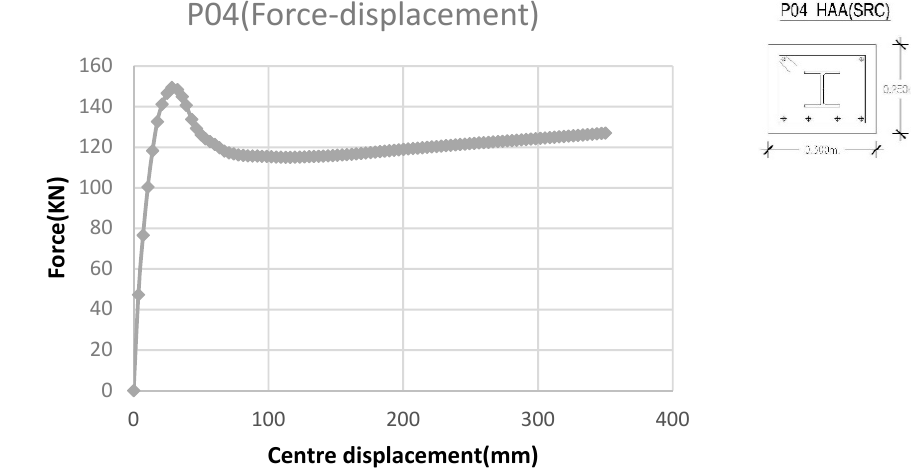
Figure 22. Force–displacement graph of the numerical model of P04.